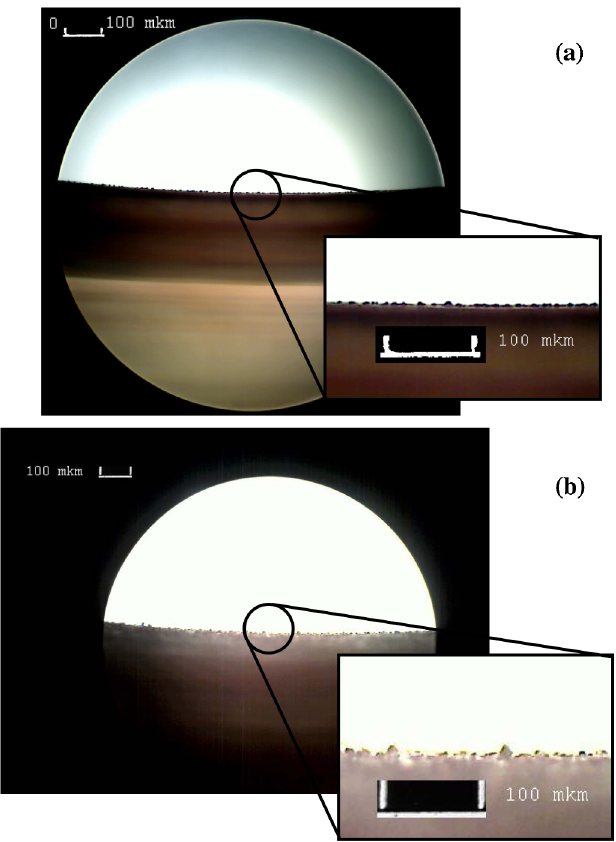
FIG. 7. Photographs (optical microscope) of the central part of the waistband after irradiation by (a) 1 : 6 (cid:2) 10 4 and (b) 4 : 8 (cid:2) 10 4 pulses (magnification of